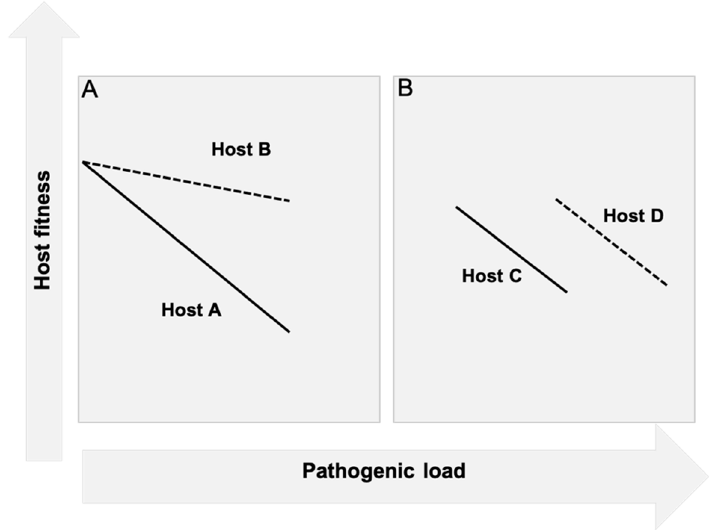
Figure 1. Reaction norm demonstrating the concept of Tolerance and Resistance. ( A ) Host fitness is plotted against bacterial burden for two different hosts (Host A, solid line, and Host B, dashed line). As the figure shows, for the same bacterial burden (same mean pathogen load in x-axis), the health cost (i.e., the change in Host fitness) of such infection is greater for host A than for host B. The slope of the curves is representative therefore, of the Tolerance capacity of each host. ( B ) Host fitness is plotted against bacterial burden once again for two different hosts (Host C, solid line, and Host D, dashed line). Host C and D have the same Tolerance capacity because the slopes of the curves are identical. However, Host D has lower Resistance capacity than Host C because the mean pathogen load is higher.